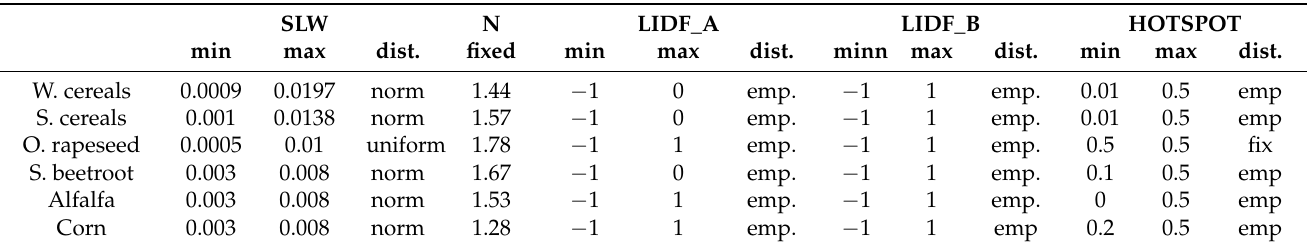
Table 2. ProSAIL inputs with different values for six crops of interest (SLW = specific leaf weight, N = leaf structural parameter, LIDFa, LIDFb and HSpot = leaf and canopy structure